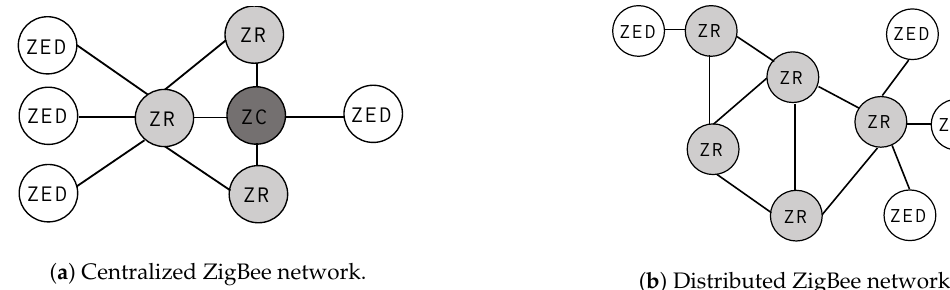
Figure 1. ZigBee 3.0 device types in centralized and distributed